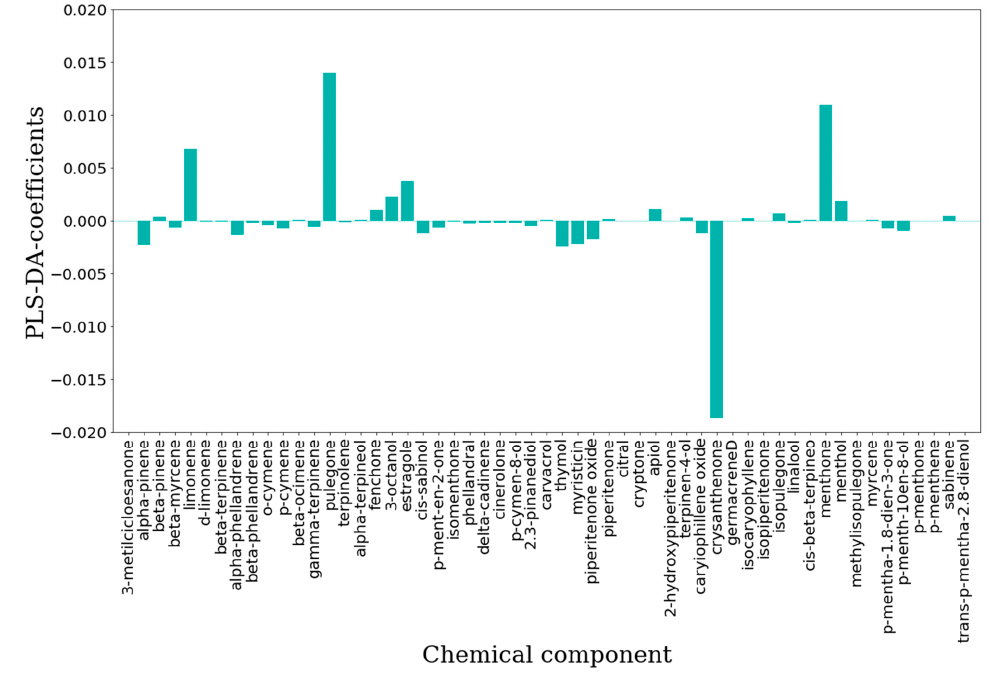
Figure 9. Features importance plot obtained from the CC 50 -PLS-DA- classification. On the y-axis are reported the PLS-DA coefficients while in the x-axis are listed the chemical